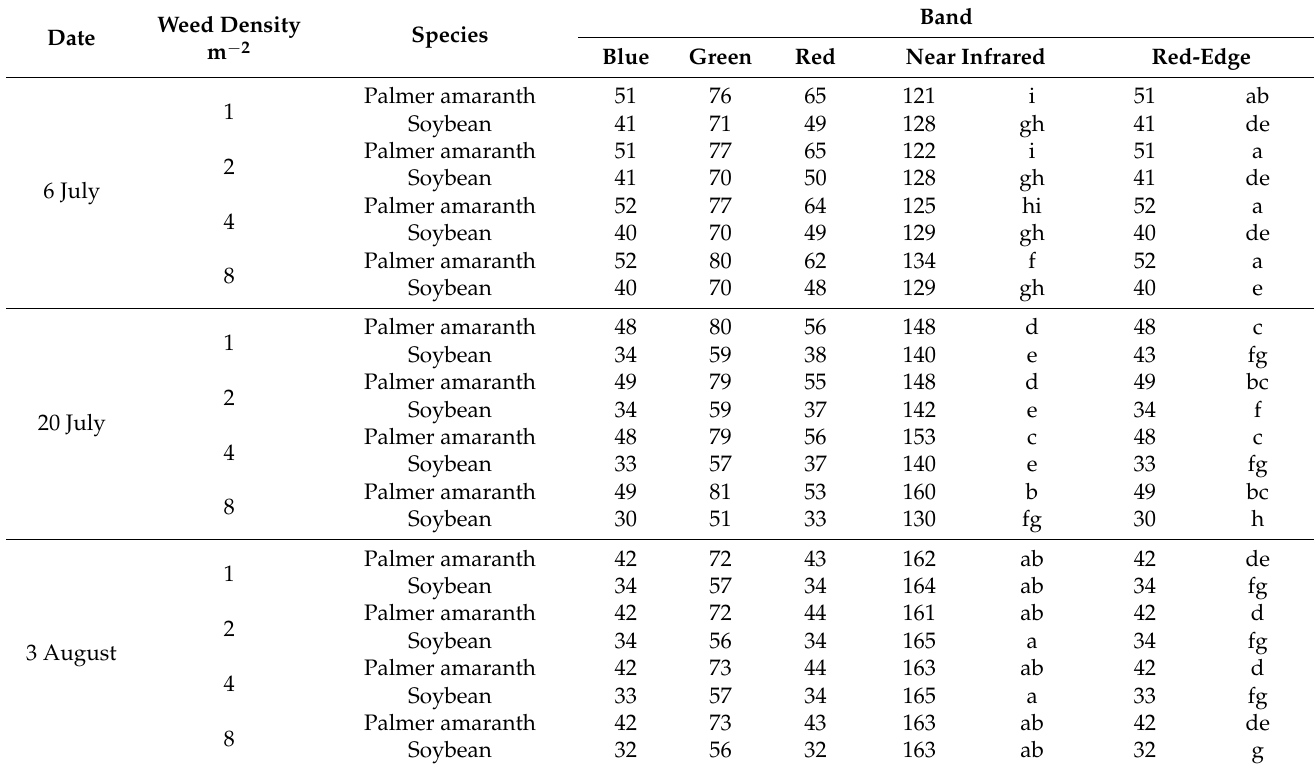
season (20 July), but decreased by late-season (3 August) to levels significantly lower than those observed in the early-season imagery. As with Palmer amaranth, soybean spectral reflectance in the NIR waveband significantly increased through the season and reflectance values were highest on 3 August. Table 4. Spectral reflectance values of Palmer amaranth and soybean across dates and weed densities from aerial imagery collected from an unmanned aerial vehicle at an altitude of 15 m at Rocky Mount, NC in 2017